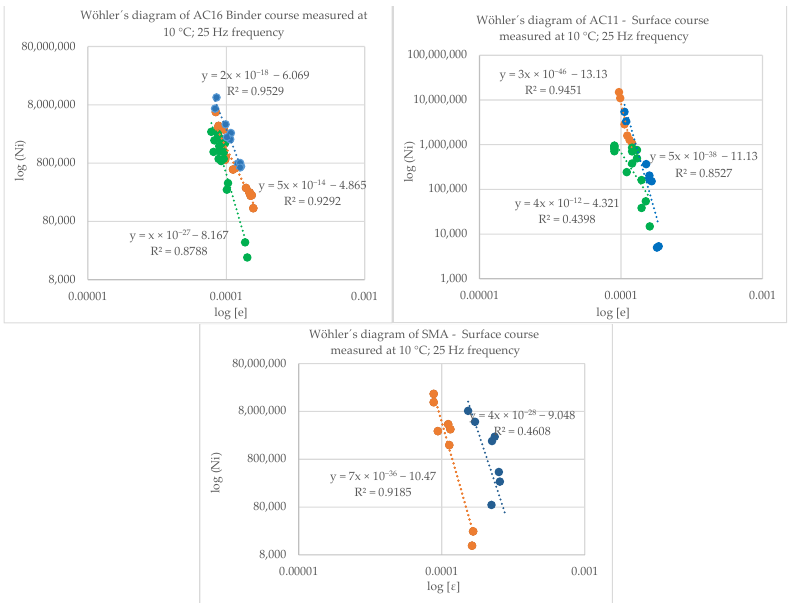
Figure 4. Wöhler’s diagram of evaluated mixtures, where CA 50/70 mixtures are marked in green, CA50/70 with 3% of SBS polymer mixtures are marked in orange, and 10/40-65 mixtures are marked in blue.